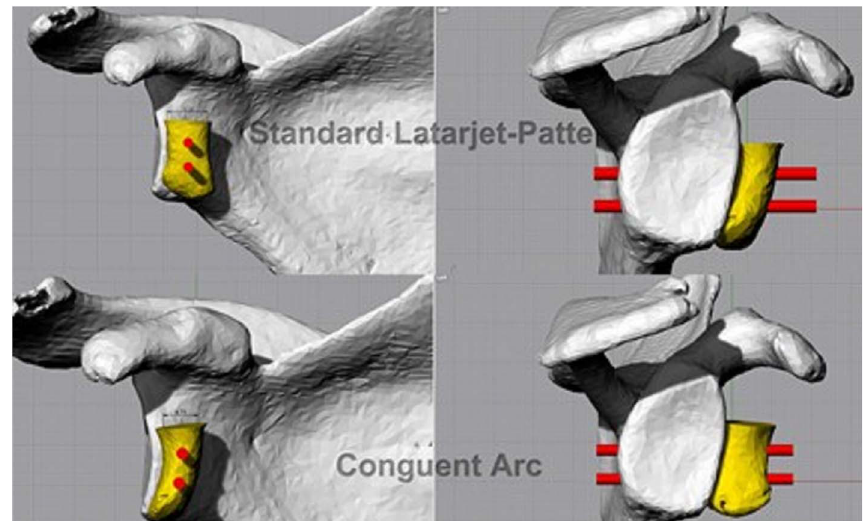
Figure 6. 3D digital planning of a Latarjet and Congruent Arc procedure.